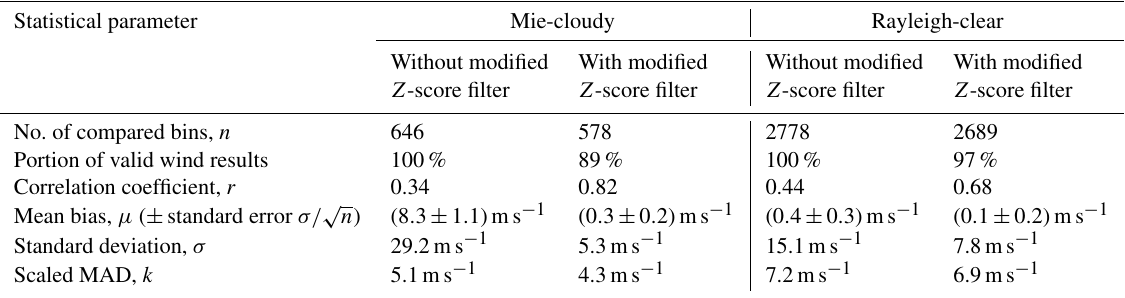
Table 2. Statistical comparison of the Aeolus L2B Mie-cloudy and Aeolus L2B Rayleigh-clear winds against the ECMWF model background winds for all underflights performed during the AVATAR-T campaign. The corresponding scatterplots and histograms are shown in Figs. 2 and 3, respectively. The statistics are derived after the adaptation of the ECMWF model data to the respective L2B measurement grids. The statistical parameters are given without and with the removal of outliers according to the modified Z score ( | Z m | > 3 . 5). Statistical parameter Mie-cloudy